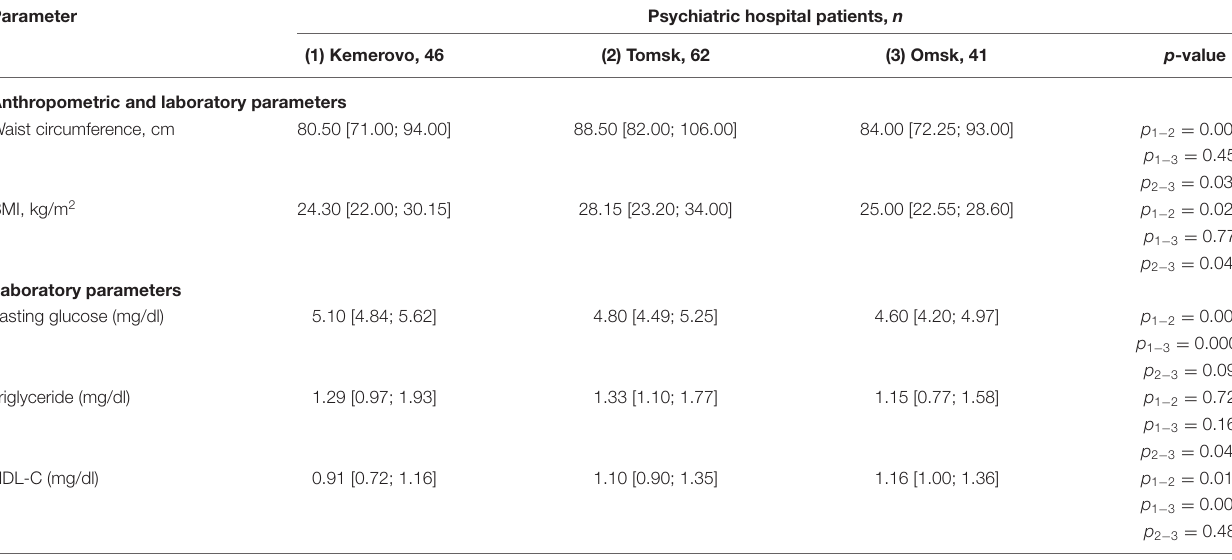
TABLE 9 | Comparative characteristics and evaluation of anthropometric and laboratory parameters in the female part of the study population (Me [Q1; Q3]).